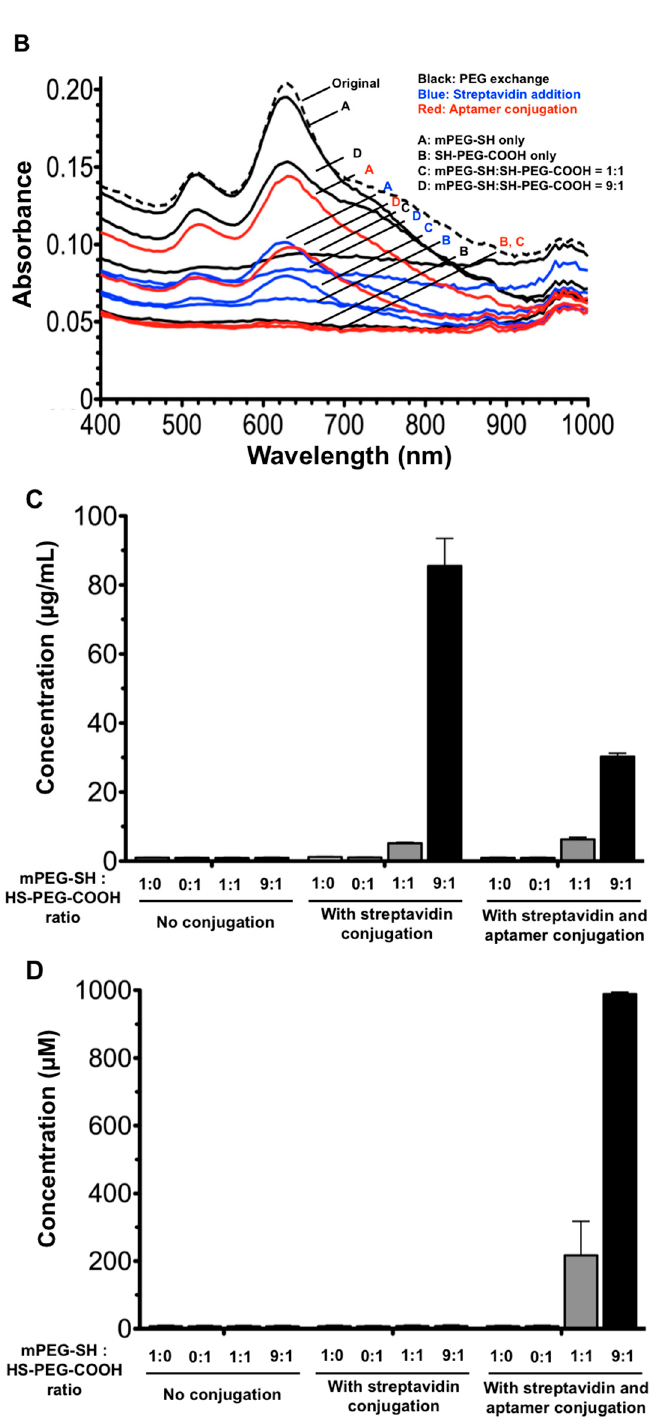
Figure 3. AuNR functionalization. Photographs ( A ) and absorbance spectra ( B ) of AuNRs upon PEG displacement, streptavidin addition, and aptamer conjugation during surface modification with different ratios of mPEG-SH:HS-PEG-COOH. The blue color represents the non-precipitated, suspended AuNR, while the colorless change indicates that AuNR precipitation has occurred. The bar chart shows the evaluation of streptavidin ( C ) and aptamer ( D ) binding during AuNR functionalization. Fluorescence SYPRO red dye was used to evaluate the amount of streptavidin protein bound, and DNA binding fluorescence SYBR safe dye was used to evaluate the amount of bound aptamer DNA.